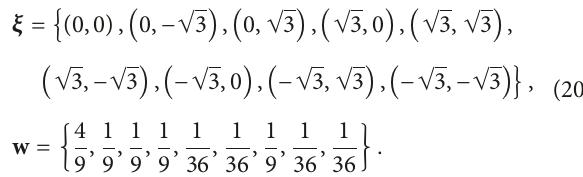
Table 1: Cubature points and corresponding weights for one dimension (𝑚 = 1, 2, 3, 4, 5) . 𝑚 {𝜉} {𝑤} 1 {0} {1} 2 {−1,1} 3 {−√3, 0,+√3} 4 {−2.334, −0.742, 0.742, 2.334} {0.046, 0.454, 0.454, 0.046} 5 {−2.857,−1.356, 0,1.356, 2.857} {0.0113, 0.2221, 0.5333, 0.2221,